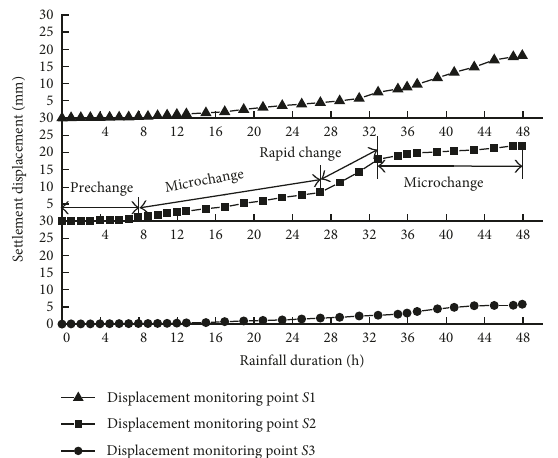
Figure 10: Variation law of settlement displacement under long- time heavy rain.